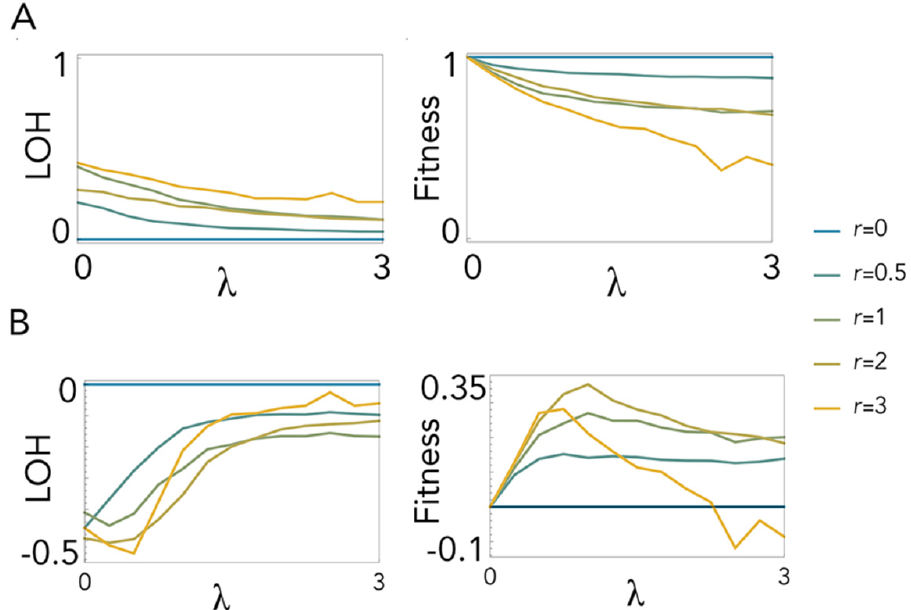
Figure 3. Loss of heterozygosity in mitosis with tetraploidy. ( A ): LOH and fitness at equilibrium. ( B ): Differences in LOH and fitness between tetraploid and diploid mitosis. LOH and fitness (for A ) or their difference (for B ) are plotted as a function of λ (the number of lethal equivalents) for different values of r (number of crossing-over event per replication) with x segregation occurring with the same probability ( x = 0.5) as z segregation. With endomitosis, a further division at interphase produces a transient tetraploid cell, which then divides twice to produce four diploid daughter cells (Figure 4A–C). Different patterns of LOH are produced depending on whether sister chromosomes (originated from the same chromosome at interphase) pair with each other or with a non-sister chromosome (one copy of the homologous chromosome). The pairing of sister chromosomes leads to no LOH irrespective of recombination, because even if a crossing over occurs, the parts that are exchanged are identical (Figure 4A). Pairing of non-sister chromosomes leads to total LOH on half of the daughter cells when there is no recombination (Figure 4B) and partial LOH if recombination occurs (Figure 4C). As a result, assuming random chromosome pairing, LOH increases with recombination rates and with the number of lethal equivalents (Figure 4D) but is always lower than in diploid mitosis (Figure 4E). Endomitosis, therefore, has an adaptive advantage in the presence of recombination. This advantage increases with the probability ( s ) of sister chromosome pairing (Figure